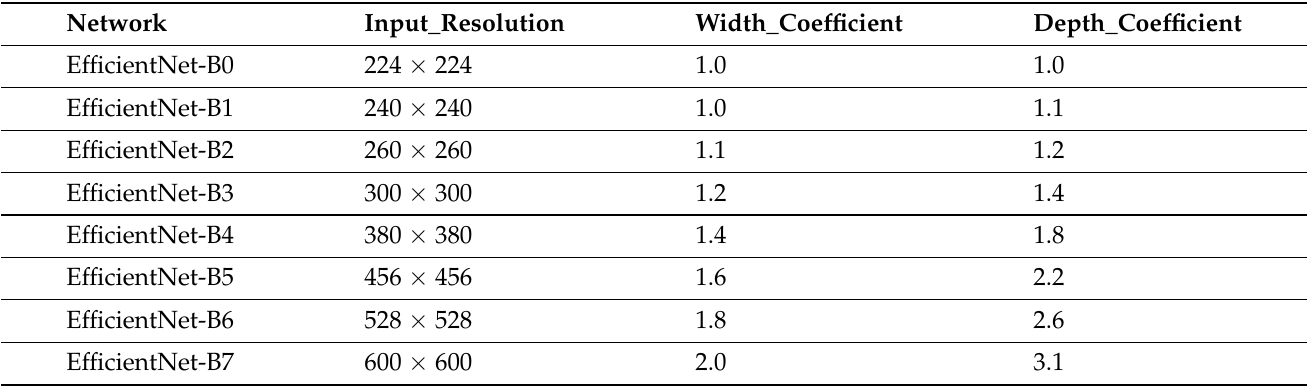
Table 3. EfficientNet compound scaling